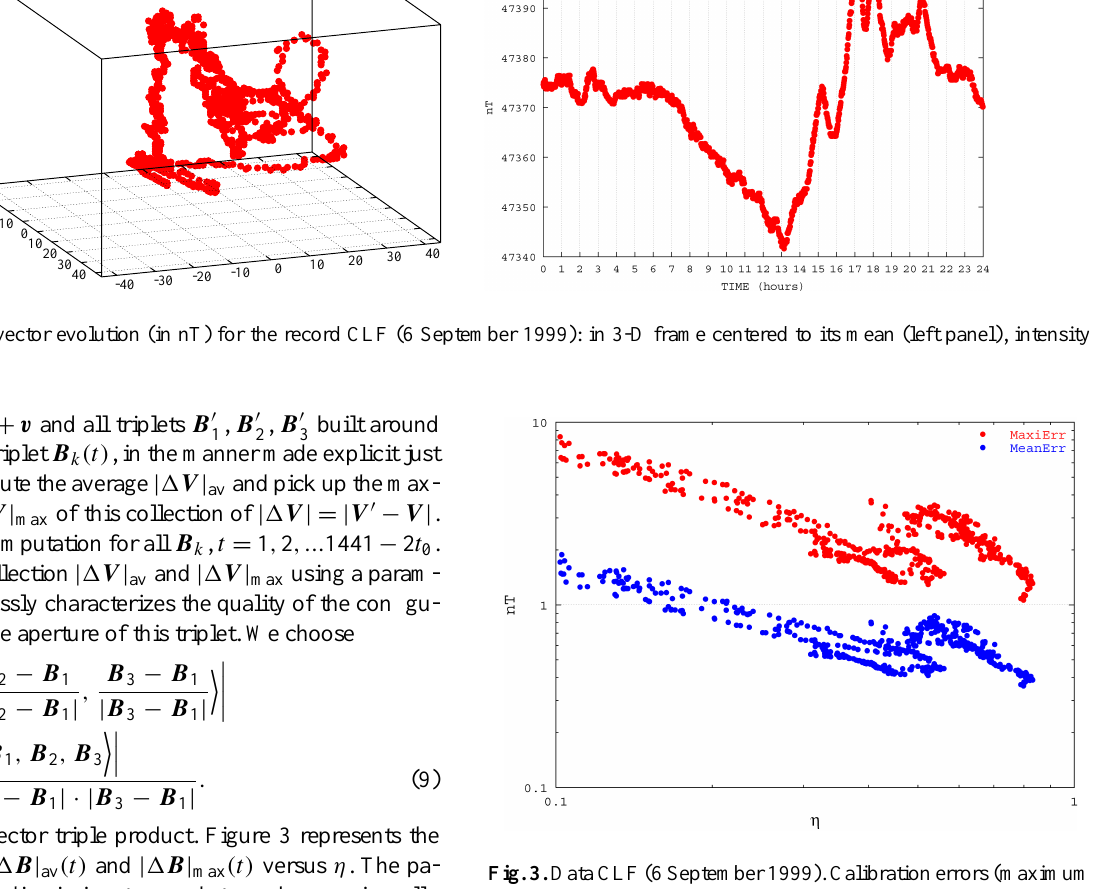
Fig. 3. Data CLF [06.09.1999]. Calibration errors (maximum and average) in nT for | v | =50nT, εb =0.75nT, Fig. 3. Data CLF (6 September 1999). Calibration errors (maximum and average) in nT for | v | =50nT, εb =0.75nT, delay t 0 =6h (see delay t 0 =6h (see main text). main